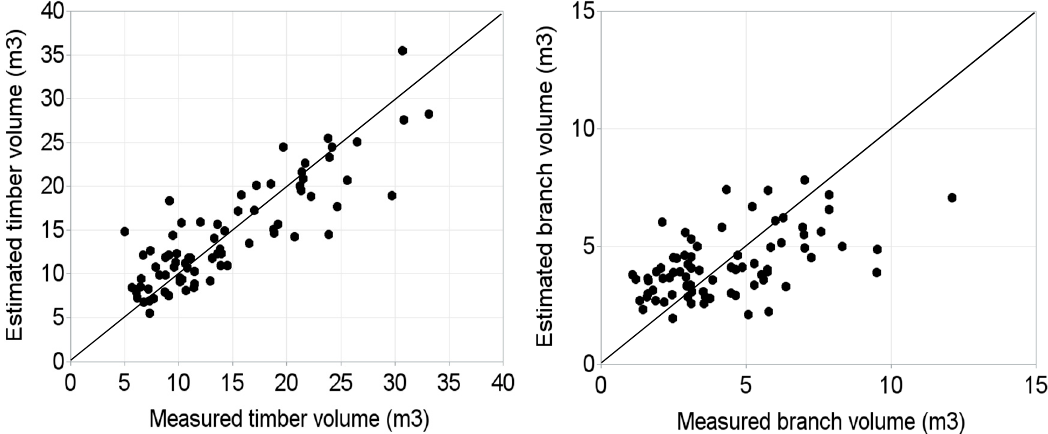
Figure 7. Estimated volumes by timber volume prediction model (Equation 3) and branch volume prediction model (Equation 4) against measured volumes with a diagonal 1:1 line passing through data points.